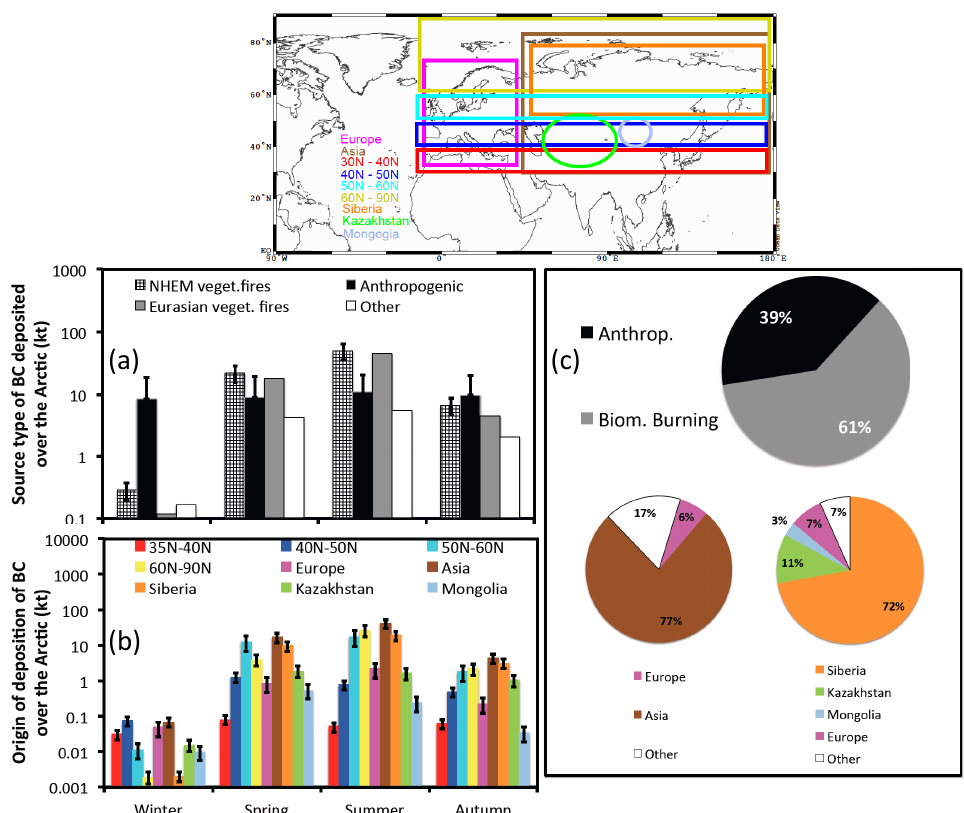
Figure 5. (a) The nine geographic regions of BC emission in northern Eurasia defined for this study. (b) Seasonal values of BC emitted from all fires in the Northern Hemisphere (NHEM), anthropogenic sources (black), and northern Eurasian vegetation fires (grey) deposited in the Arctic for the period of 2002–2013. (c) Contribution of several geographic regions to the Arctic BC deposition. Colours are used according to the ones used in panel (a) . Red stands for regions within 35–40 ◦ N, dark blue for 40–50 ◦ N, turquoise for 50–60 ◦ N, yellow for regions located above 60 ◦ N (60–90 ◦ N), magenta for Europe, brown for Asia, orange denotes Siberia, green for Kazakhstan, and light blue for Mongolia. (d) Pie-charts showing the origin of BC deposition in the Arctic from anthropogenic sources (MACCity), vegetation fires in northern Eurasia (FEI-NE) and BB outside northern